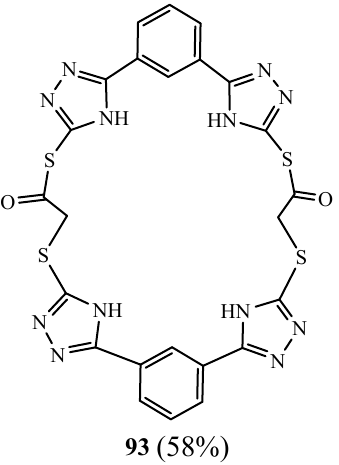
Figure 23. Structure of tetra-triazolic macrocycle 93. (Reprinted with permission from ref. [42]. Copyright 2012 John Wiley and Sons)